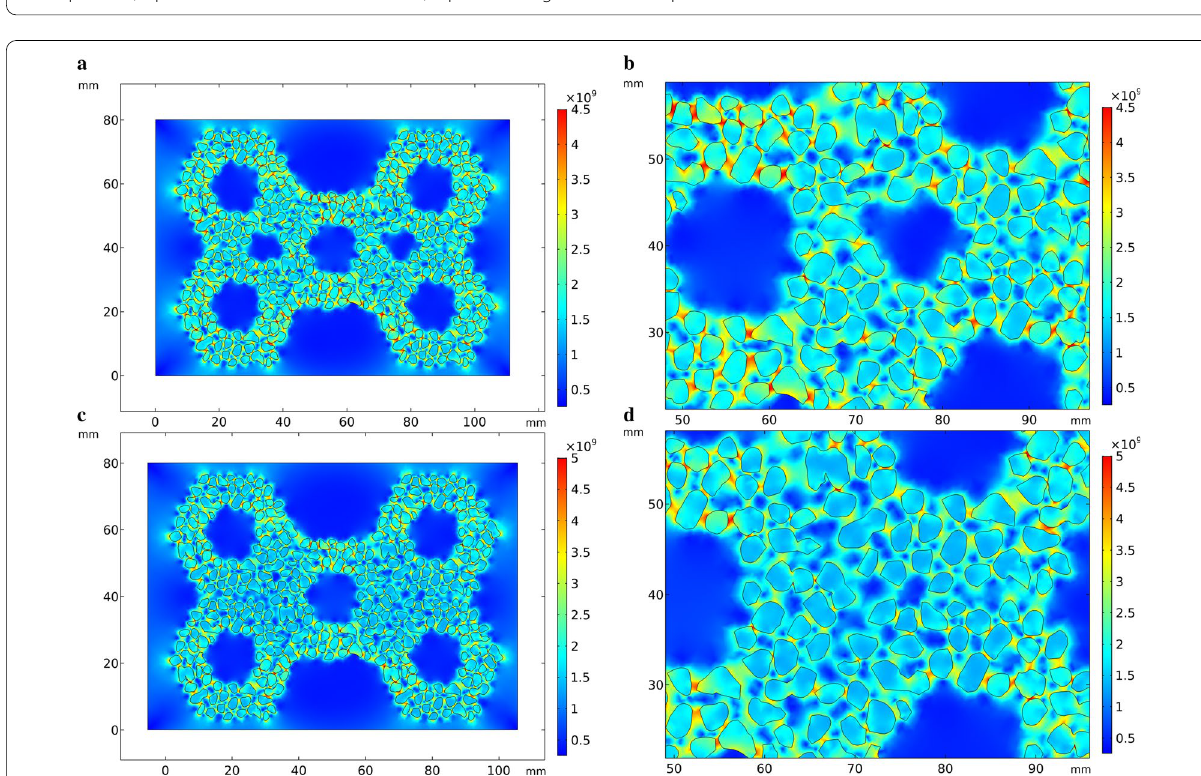
Fig. 6 Thermal stress distribution during solidification in the optimized model. a Initial perform, b partial enlarged view of the initial perform, c preform with circular holes added, d partial enlarged view of the perform with circular holes